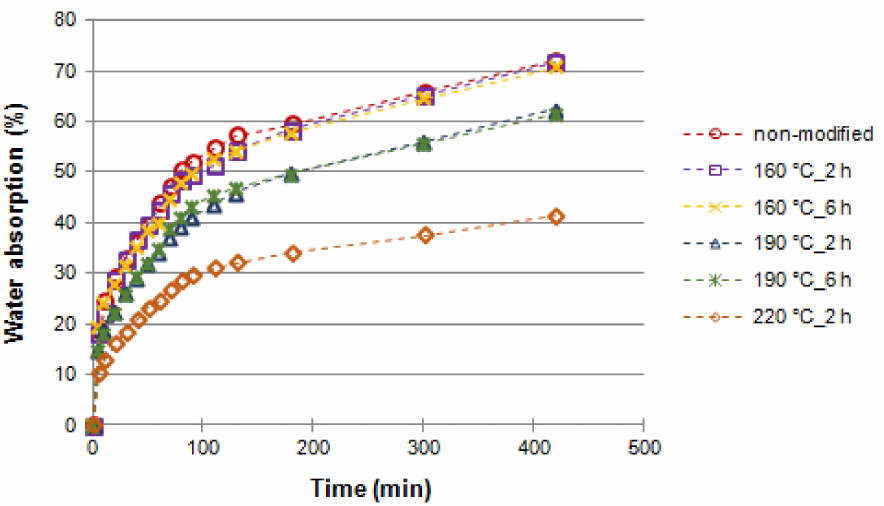
Figure 3. Water absorption (WA) of black poplar thermally modified in nitrogen atmosphere during the first 7 h of